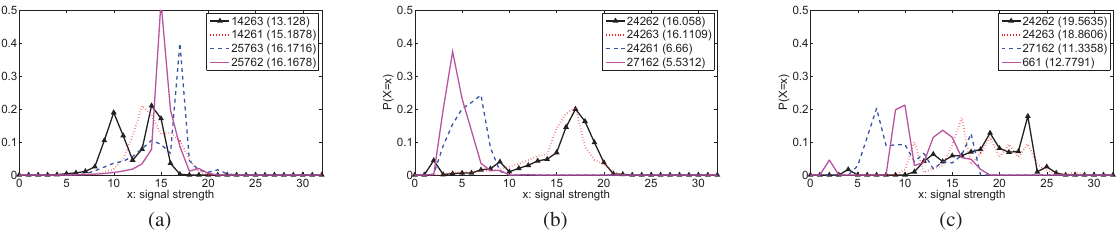
Figure 5: The personalized signatures for three APs: (a) AP X (b) AP Y , and (c) AP Z . The distance between AP X and AP Y is about 7 km , AP Y and AP Z is about 30 meters . AP Y and AP Z are located in the same building. The observed base station IDs and their average signal strengths are given in the